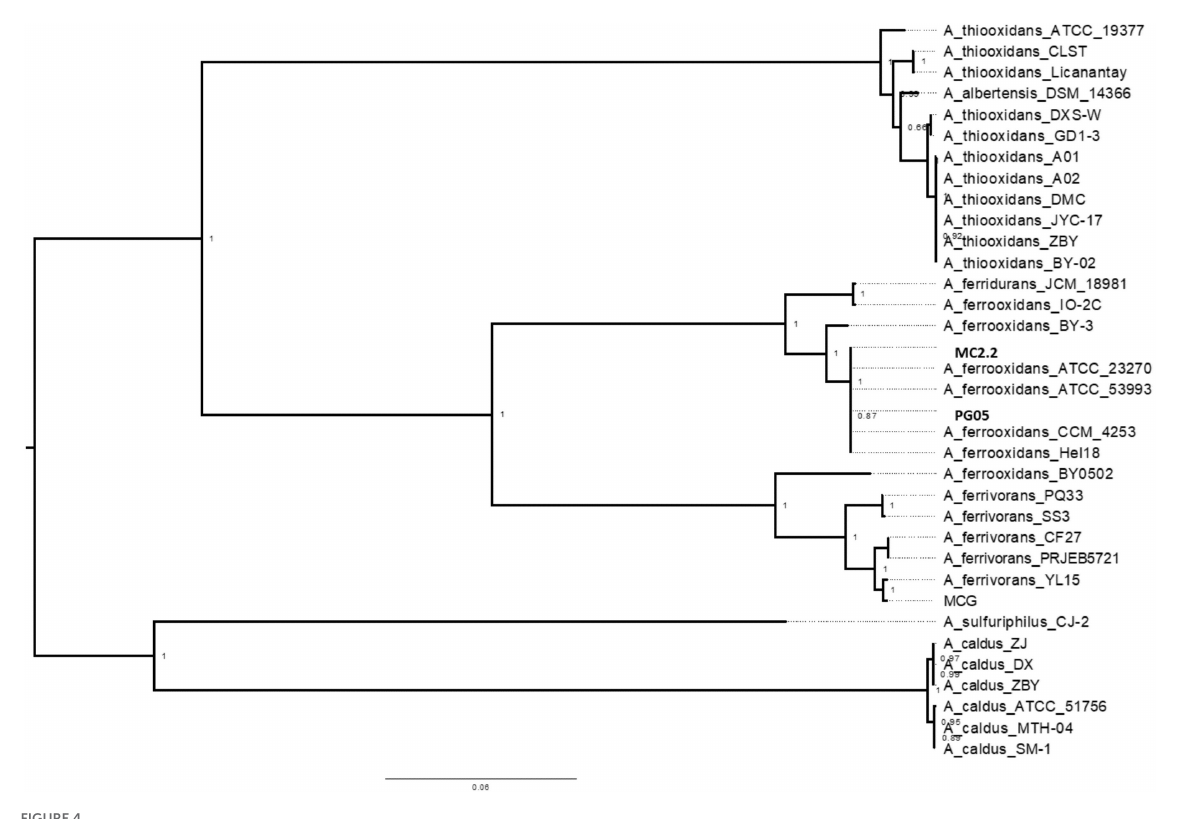
FIGURE4 Dendrogram constructed by the maximum-likehood method showing the phylogenetic relationships using 31 gene sequences of bacterial species of the genus Acidithiobacillus . Bootstrap values expressed as percentages of 1,000 replications are shown. Bars represent 1 substitution per 100